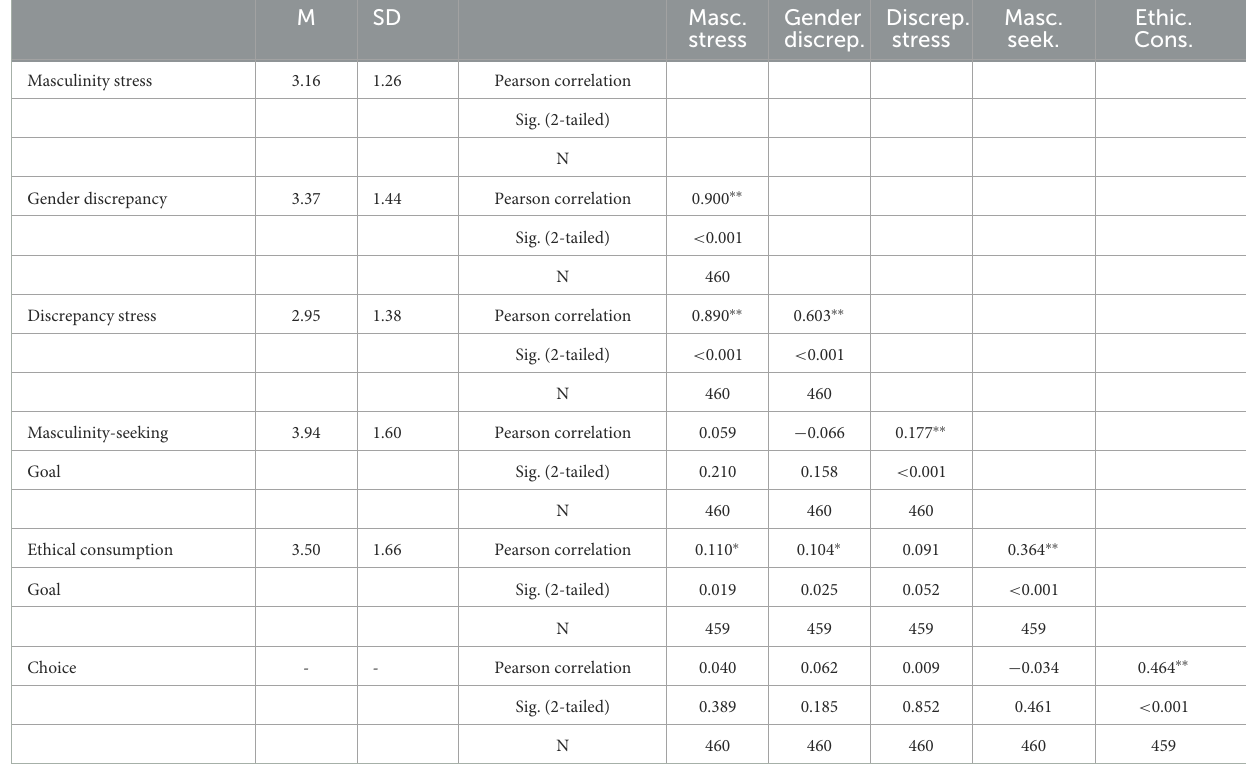
TABLE 5 Study 3 descriptives and zero-order intercorrelations. M